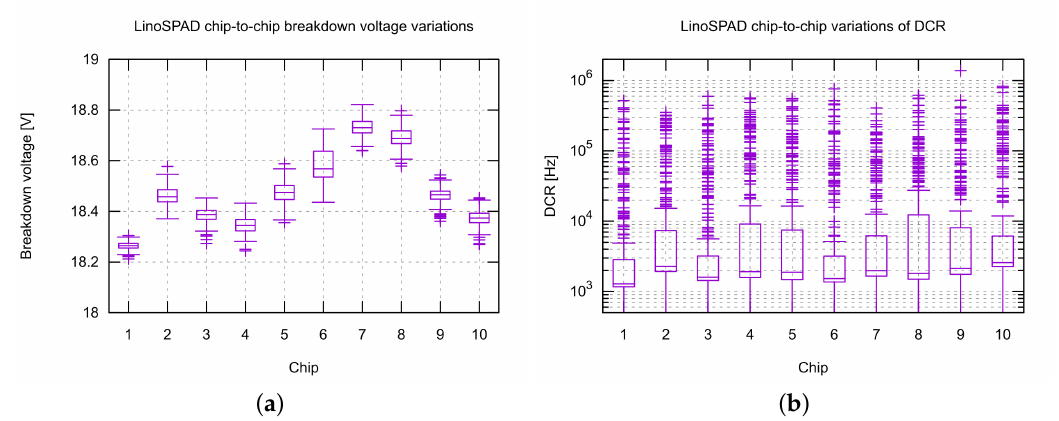
Figure 15. Chip-to-chip variations of: breakdown voltage ( a ); and DCR ( b ). The breakdown voltage has a typical deviation below 100 mV, but chip-to-chip variations can exceed 500 mV. Individual characterization remains therefore important. The difference in DCR is not as pronounced, yet there seem to be chips with significantly better than average